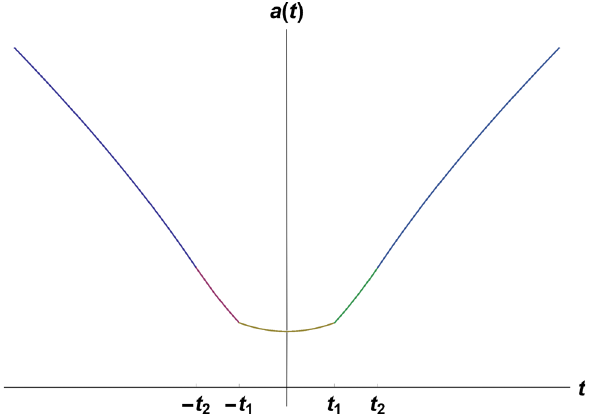
Fig. 3 The CSTB universe undergoes five phases: Tachyon matter dominatedcontraction,deflation,smoothbounce andlockedinflationat the peak of the tachyon potential when the tachyon is locked by the fast oscillations of the Higgs field. After that a period of tachyon-matter- dominated rolling expansion